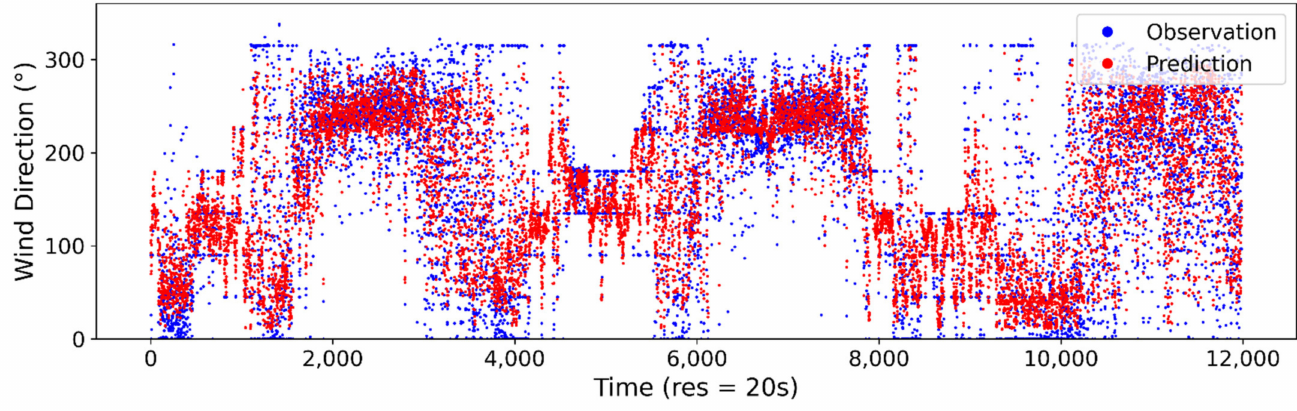
Figure A6. Estimated vs. observed wind direction at 20-s sampling interval using ANN model.